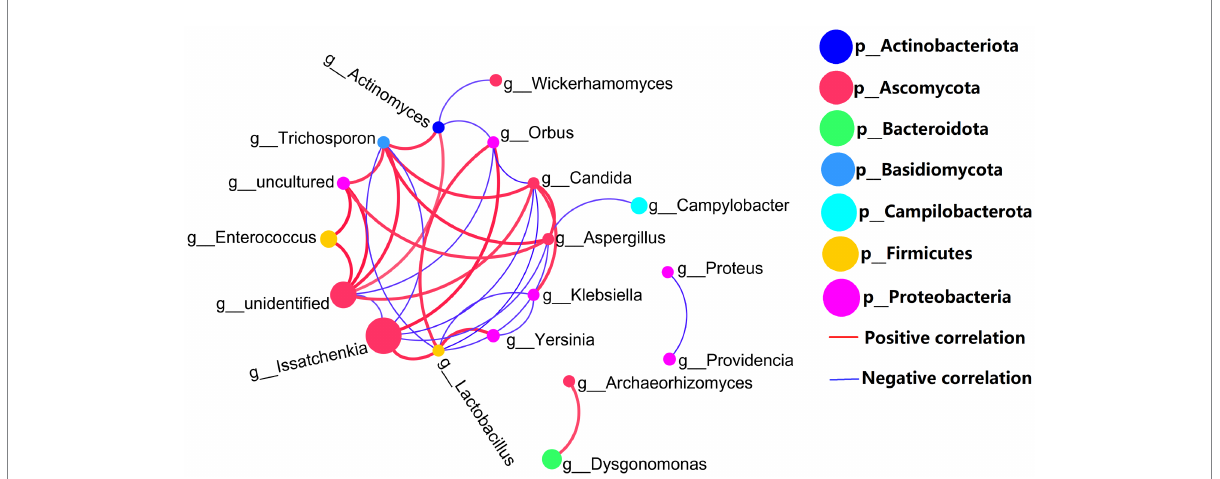
FIGURE 4 Genus levels of the top 20 abundances of all samples co-occurrence network, 16S rDNA sequence and ITS1 sequences, the average number of neighbors for this network is 4.429; characteristic path length is 1.956; network density is 0.341; and the clustering coefficient is